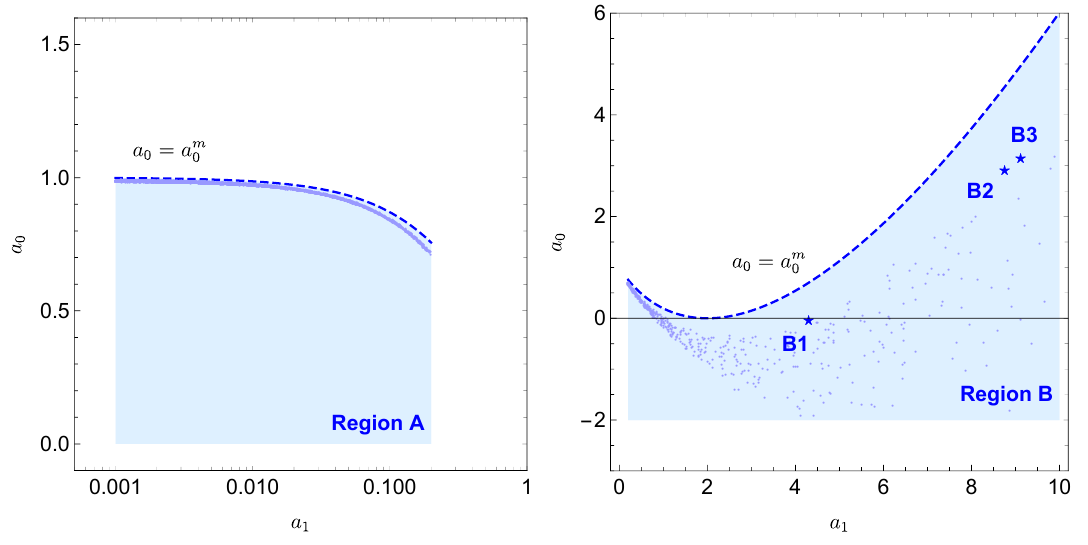
Figure 7 . Scatter plots in the ( a 0 , a 1 ) plane in the high-scale scenario with logarithmic field dependence and no cubic term at zero temperature. The benchmark points in table 2 are marked with stars.